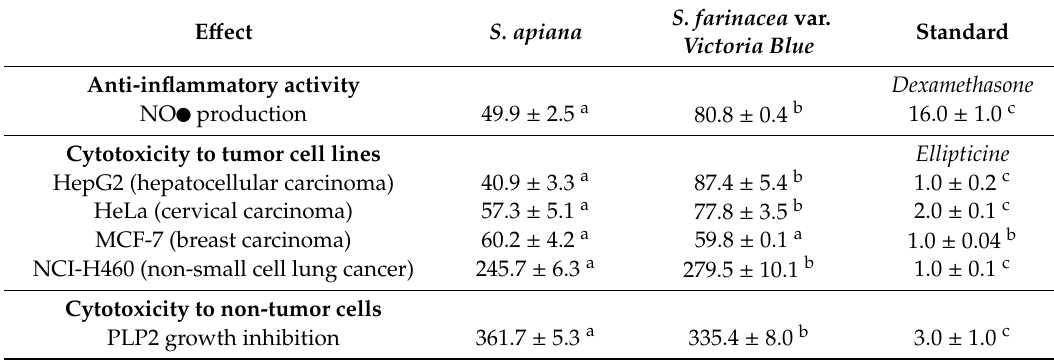
Table 2. Anti-inflammatory (EC 50 , µ g / mL) and cytotoxicity properties (GI 50 , µ g / mL) of S. apiana and S. farinacea var. Victoria Blue